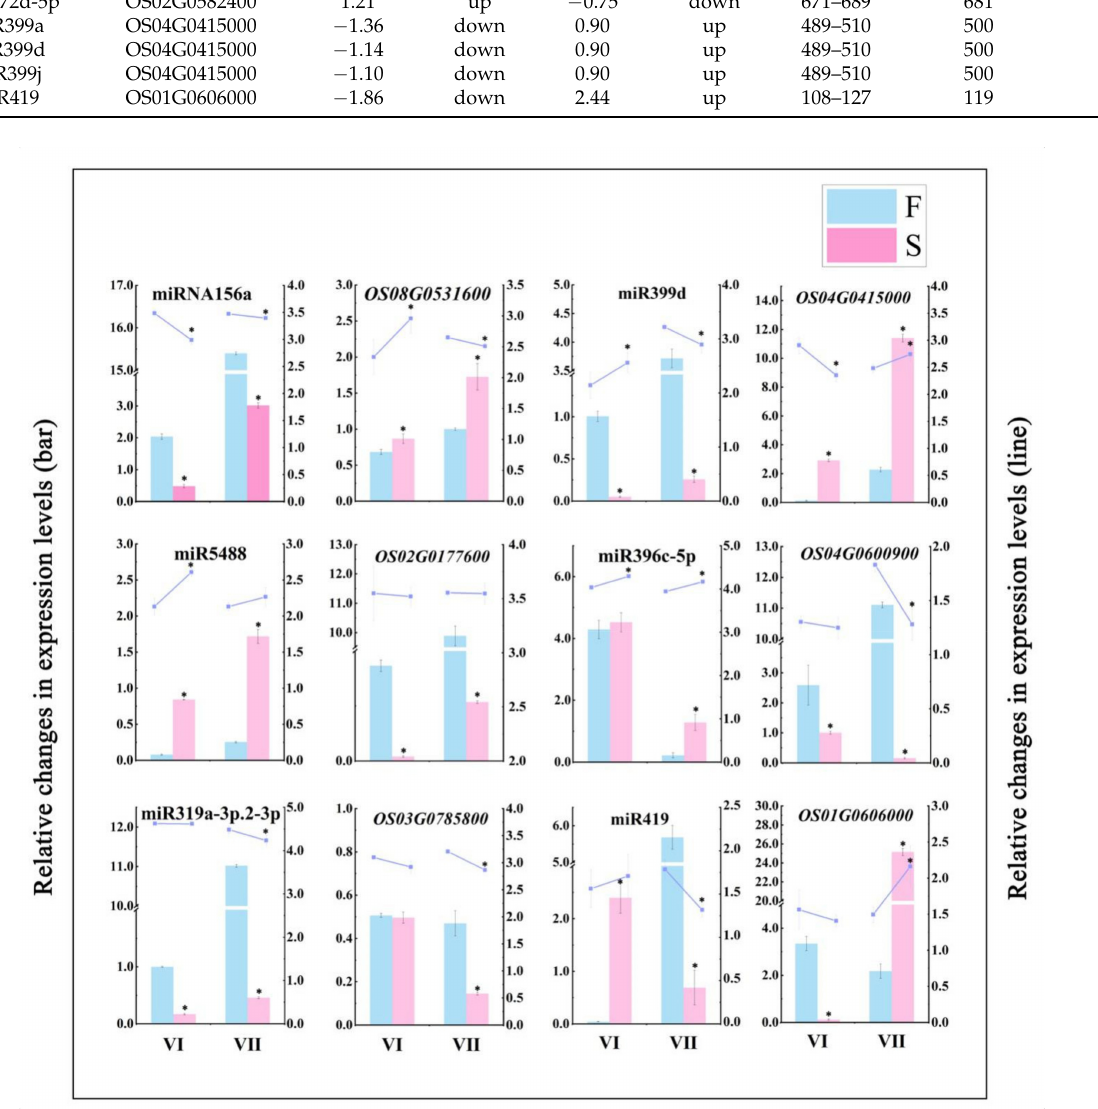
Figure 9. Validation of differentially expressed miRNAs and their corresponding target genes. Bars indicate relative changes in the expression levels of differentially expressed miRNAs and target genes, as determined by RNA-Seq. Lines indicate relative changes in the expression levels of differentially expressed miRNAs and target genes, as determined by qPCR. The average values of three biological repeats are shown. Error bars represent standard deviations. Asterisks indicate significant differences revealed by Student’s t -test at p < 0.05